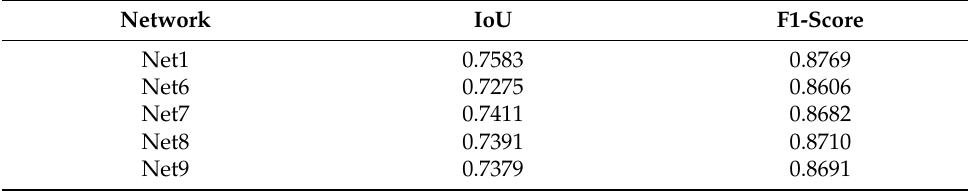
Table 3. Ablation study of our